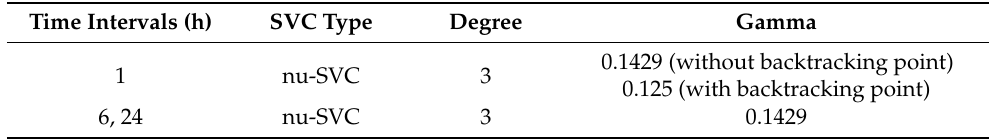
Table 4. The parameter settings of the proposed